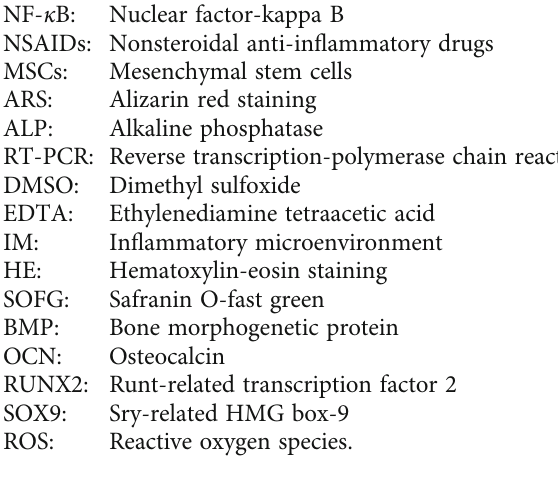
Supplementary Figure 1: original full gels images of